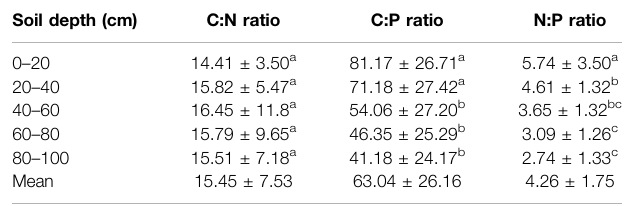
The values are means ± standard deviations. The different letters within each column indicate a signi fi cant ( p ≤ 0.05) difference among soil depths under forest